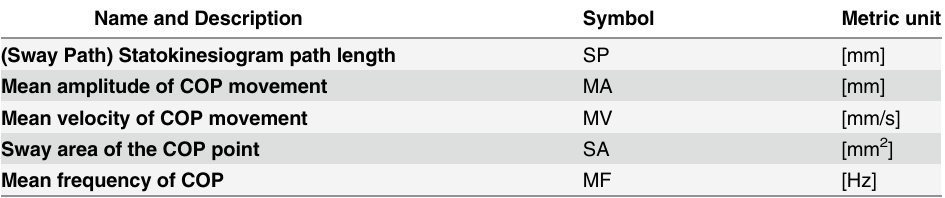
Table 1. Parameters used in the